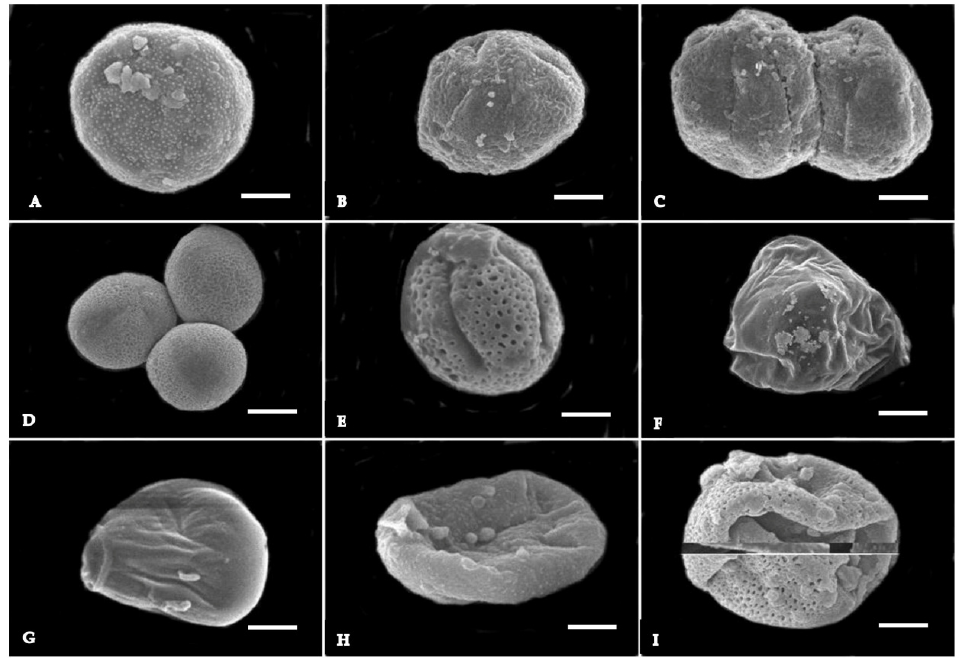
Figure 8. Scanning electron microscopy images of pollen. ( A – I ) The scale bar represents 10 µ m for Lamiaceae.